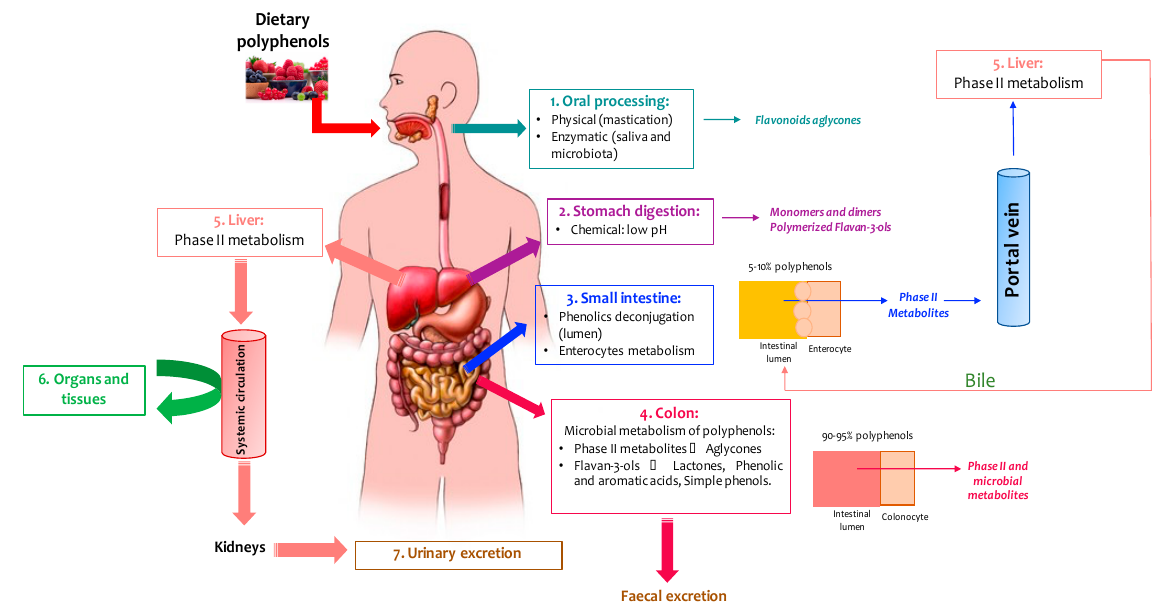
Figure 1. Schematic diagram of the steps involved in the human metabolism of polyphenols (figure adapted from others’ works [8,33,34]).